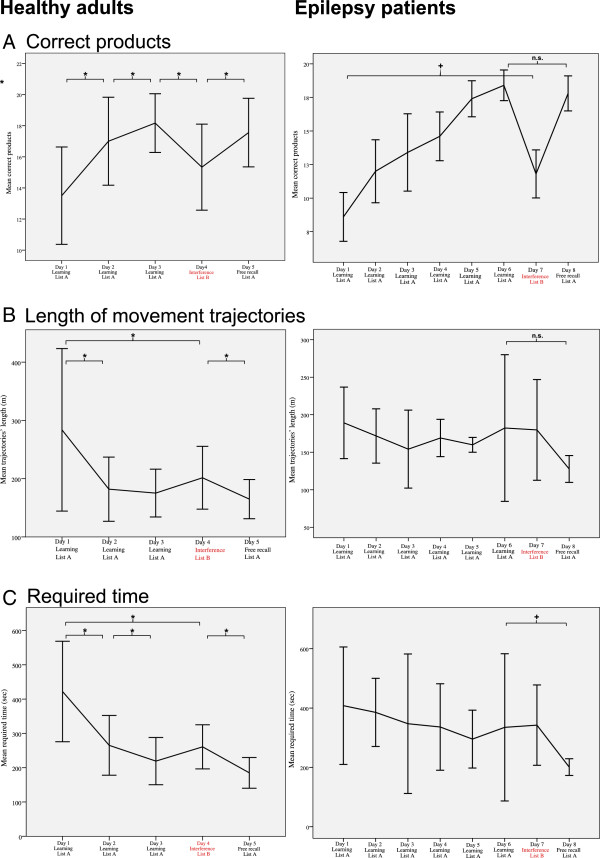
Different measures of performance in the VR task for the healthy subjects (left side of the panel) and the epilepsy patients (right side of the panel. A) The mean number of correctly bought products in the VR supermarket is shown for the five day program (left side) and for the eight day program (right side). B) The mean length of movement trajectories given in meters is shown for the five day program (left side) and for the eight day program (right side). C) The mean required time to buy all remembered products in the VR supermarket given in seconds is shown for the five day program (left side) and for the eight day program (right side). Error bars depict +/− 1 SD; “*” = significant difference between two days at p ≤ .0083 (corrected for multiple comparisons); “+” = significant difference between two days using the non-parametric Wilcoxon signed rank test to test the main hypotheses for the clinical group, p ≤ .05; “n.s.” = non- significant comparison.